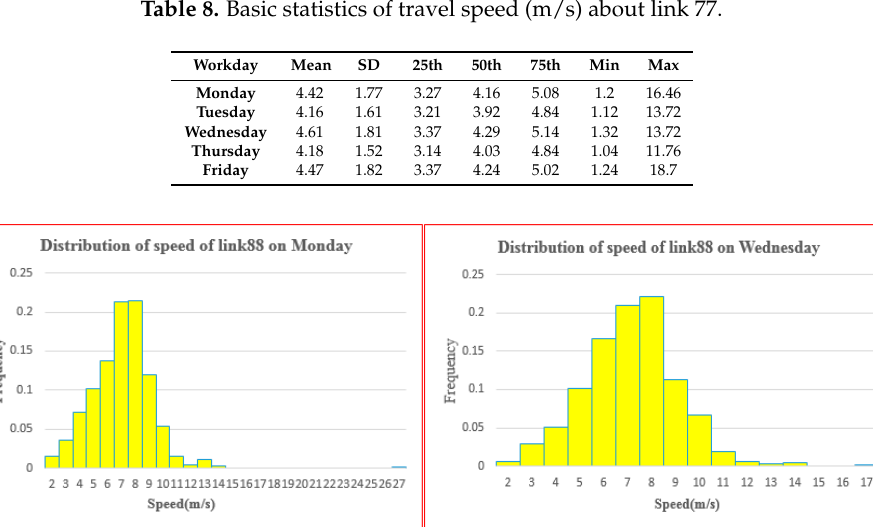
Table 8. Basic statistics of travel speed (m/s) about link 77.